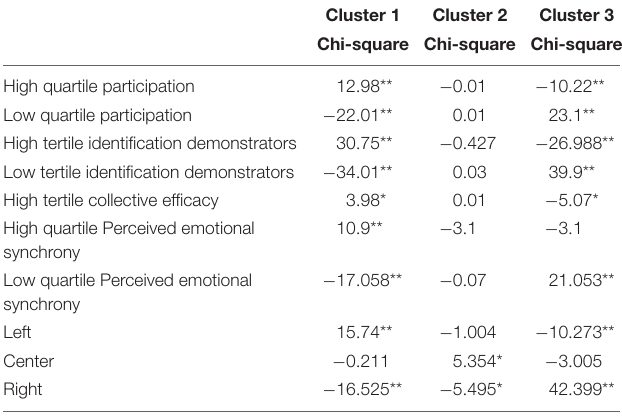
TABLE 6 | Variables associated with the